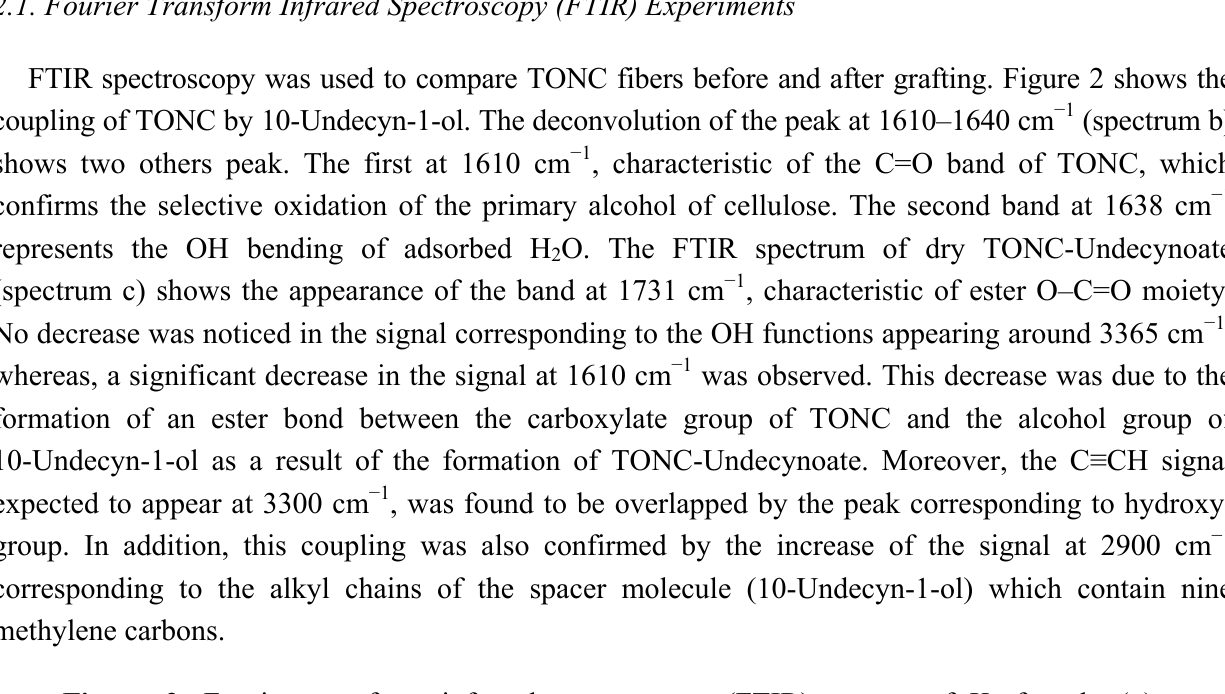
Figure 2. Fourier transform infrared spectroscopy (FTIR) spectra of Kraft pulp ( a ); Tempo-oxidized nanocelluloses (TONC) alone ( b ) and TONC-Undecynoate ( c